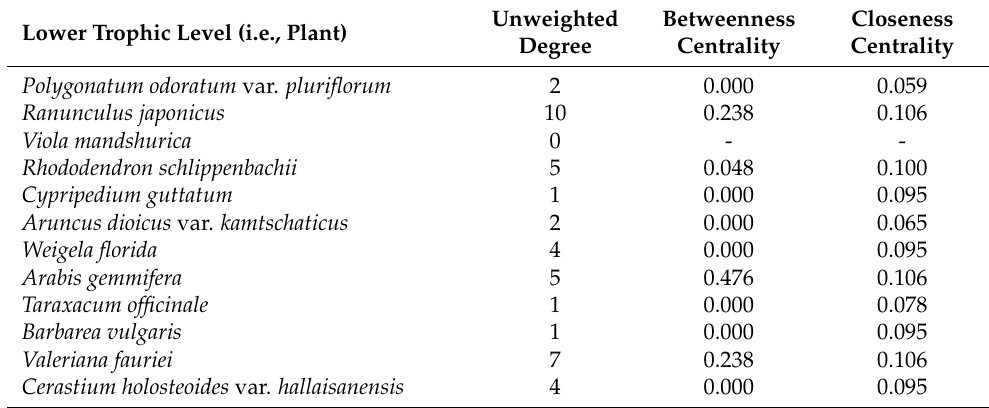
Table 5. Unweighted degree and centrality scores (BC, betweenness centrality; CC, closeness cen- trality) of plants found in the Cypripedium guttatum habitat (the Manhangjae site) in the Republic of